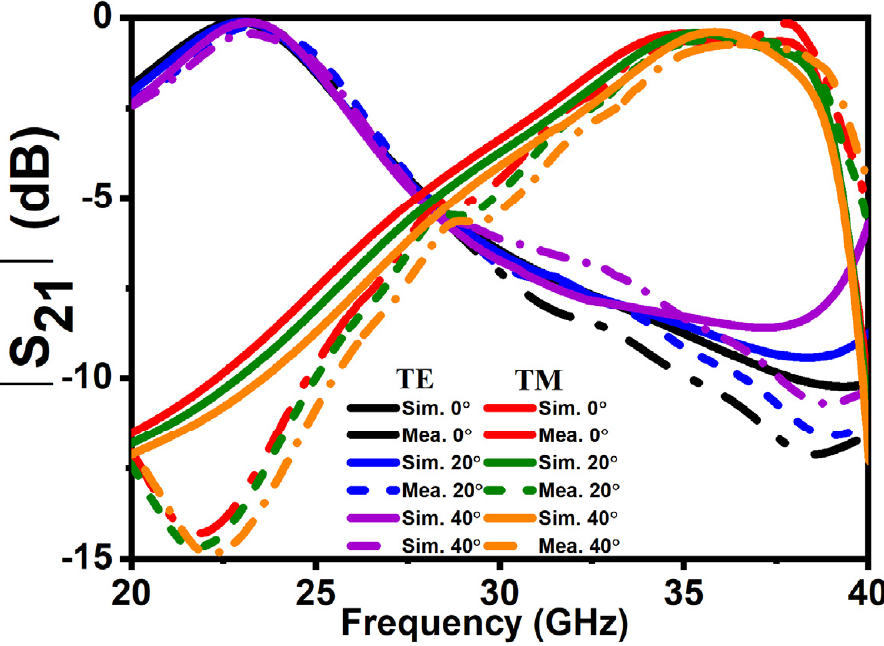
Figure 9. Transmission spectra of a proposed metasurface under normal and oblique TE and TM polarizations. Table 1. Comparison with state ‐ of ‐ the ‐ art reported work.